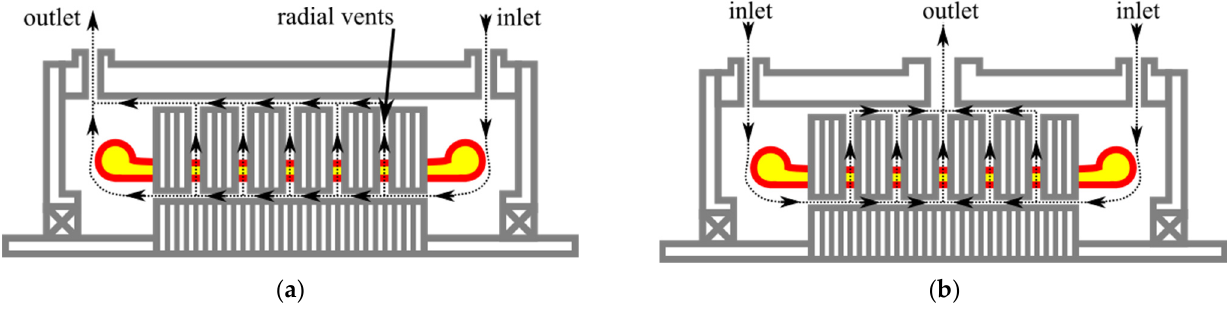
Figure 10. Symmetrical and asymmetric configurations with radial vents [87]: ( a ) asymmetric (uni- directional); ( b ) symmetrical (bi-directional).